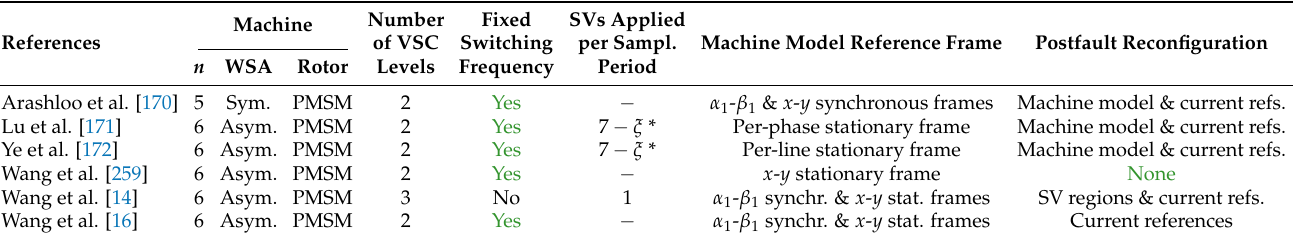
Table 9. Methods based on RFOC with current deadbeat control for tolerating phase OCs (Section 3.4.3) in multiphase applications in the